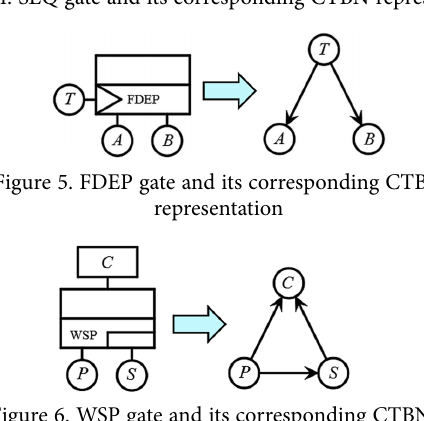
Figure 6. WSP gate and its corresponding CTBN